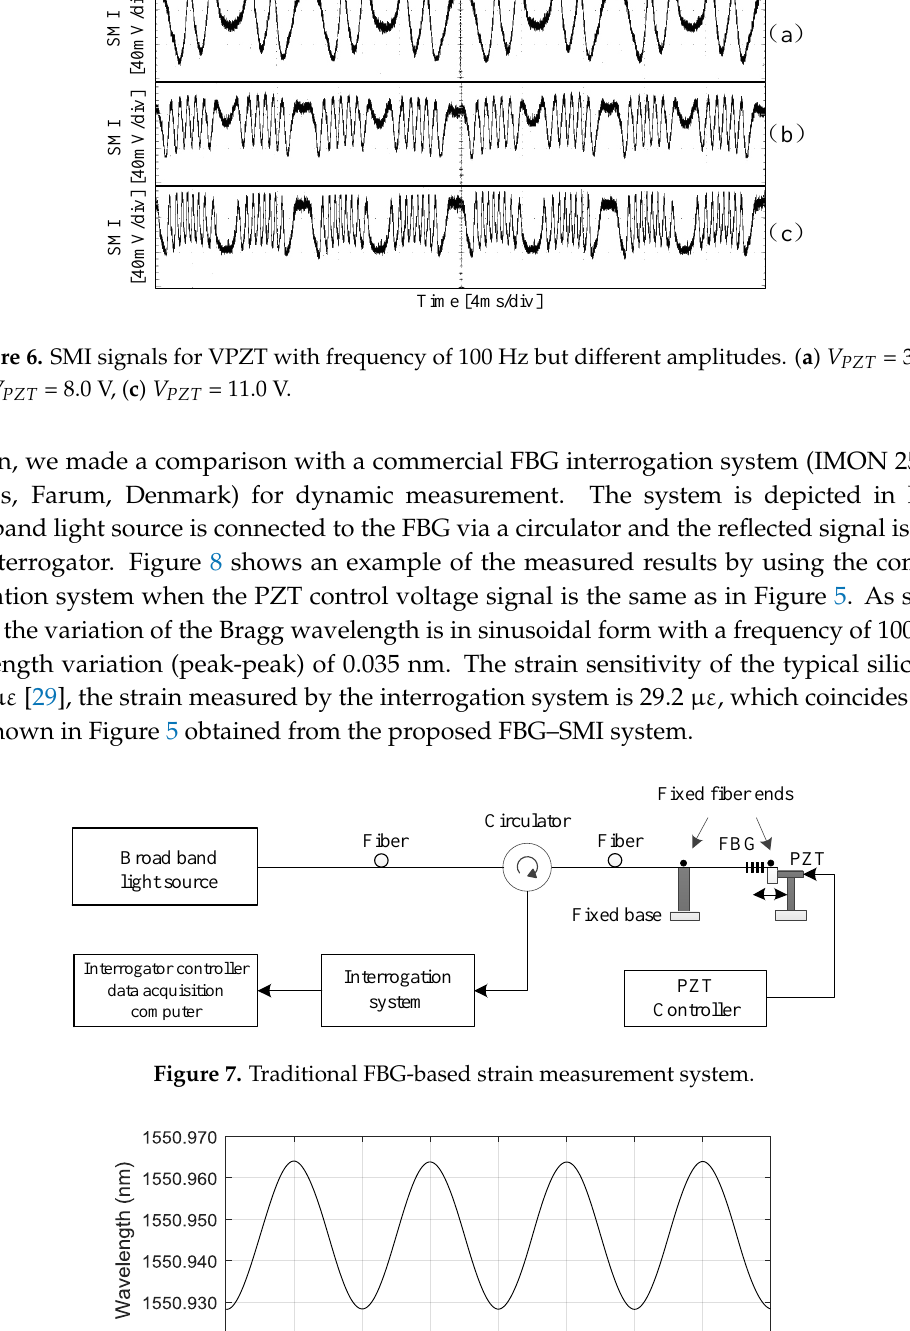
Figure 8. Experiment result by using the I-MON 256 interrogation system.